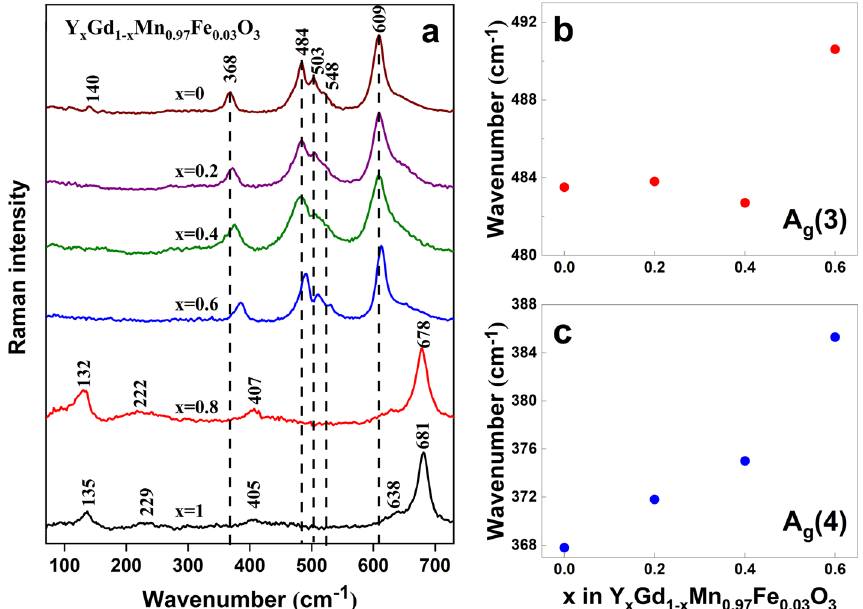
Figure 4. Composition dependent Raman spectra of polycrystalline Y x Gd 1−x Mn 0.97 Fe 0.03 O 3 compounds. Intensities are normalized to the intensity of the most intense band and spectra are shifted vertically for clarity. The excitation wavelength is 532 nm (0.6 mW) ( a ). Composition variation of Raman wavenumber of Y x Gd 1−x Mn 0.097 Fe 0.03 O 3 compounds for A g (3) mode associated with asymmetric stretching vibration of oxygens ( b ) and A g (4) mode associated with out-of-phase rotation of MnO 6 octahedra ( c ). Parameters of the bands were determined by fitting the experimental spectra using GRAMS/Al software (version 8.0, https ://www.therm ofish